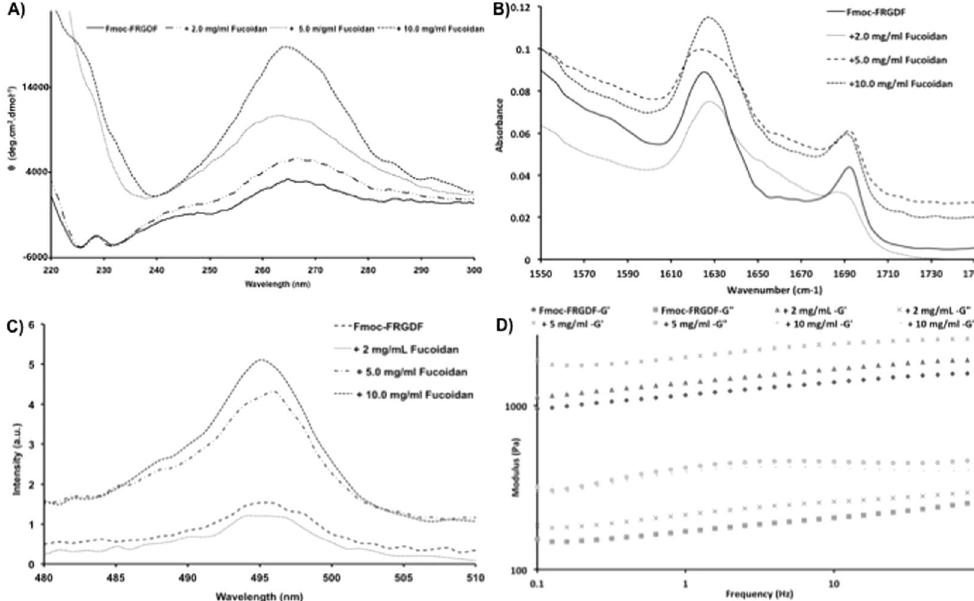
Figure 4. Spectroscopic analysis of peptide assembly with increasing concentrations of fucoidan: ( A ) CD spectra showing increased magnitude in the region located at 260–270 nm associated with increasing supramolecular organisation; ( B ) FT-IR spectra showing consistent β -sheet formation across all conditions suggesting the assembly mechanism of the peptide is not disrupted by increasing concentrations of fucoidan ( C ) Fluorescence spectra of the region 480–510 nm showing increasing fluorescence from Fmoc ordering into a consistent dominant aggregate. ( D ) Rheological Characterisation of the hydrogels. Typical frequency sweeps showing elastic (G’) and loss (G”) moduli, where the increase in fucoidan is associated with a increase in